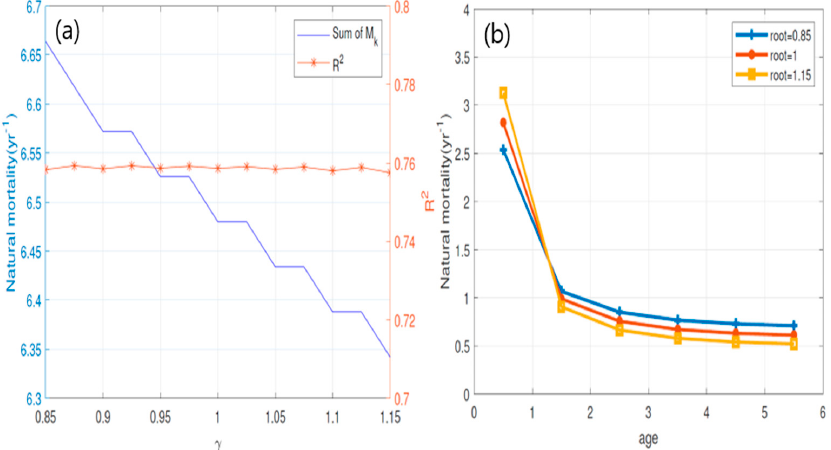
Figure 6. ( a ) Variation of ∑𝑀 (cid:3038) and R 2 when γ is 0.85 to 1.15; ( b ) Estimated natural mortality of sandfish at all ages for each γ = 0.85, 1, and 1.15.